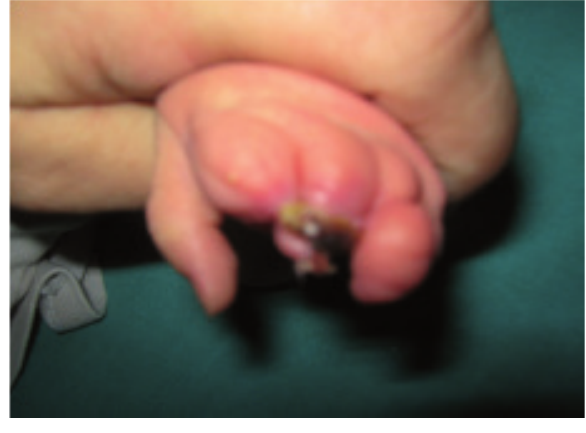
Figure 1. Distal and middle phalanx of left middle finger was gangrenous with amniotic constriction bands at the base.